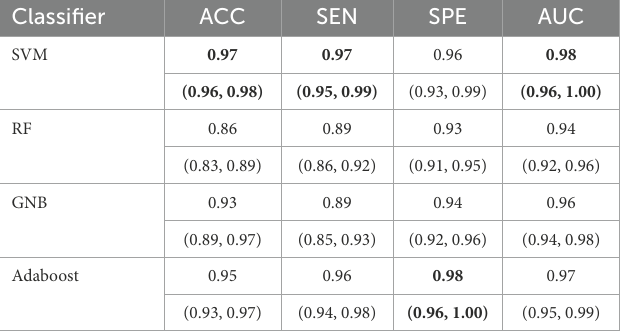
TABLE 3 Classification results of different classifiers in the training set.